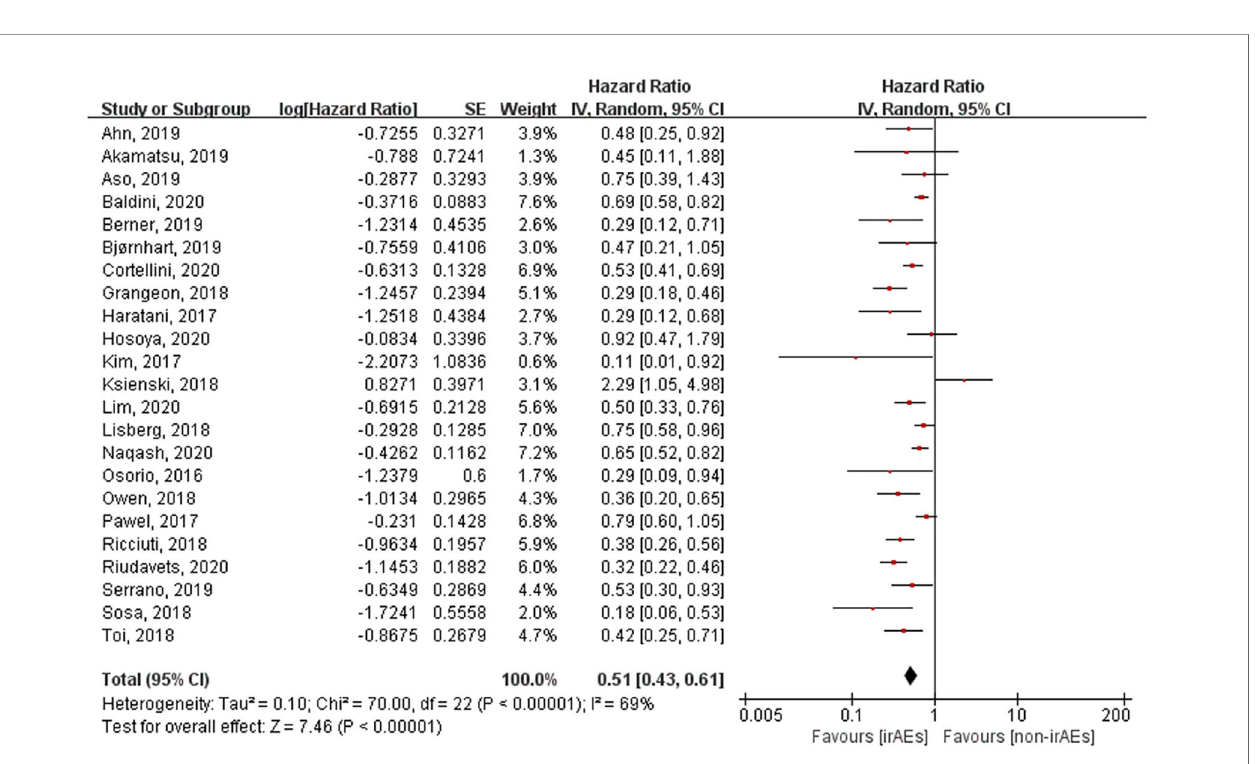
Frontiers in Oncology |